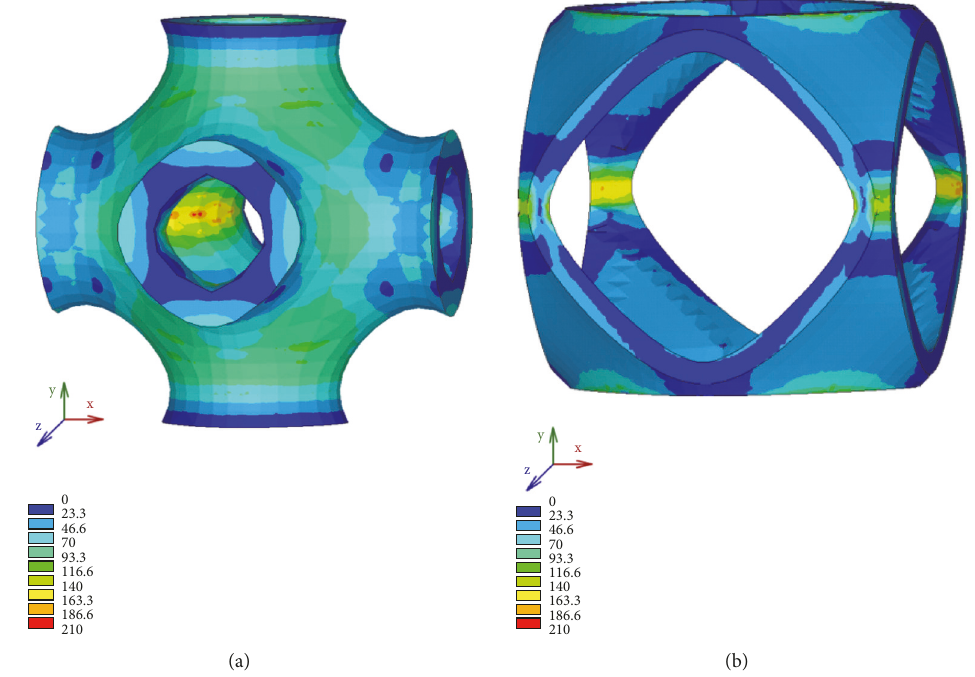
Figure 20: Von Mises stress distribution for different values of the parameter s: (a) 𝑠 = 0 .85; (b) 𝑠 = 1